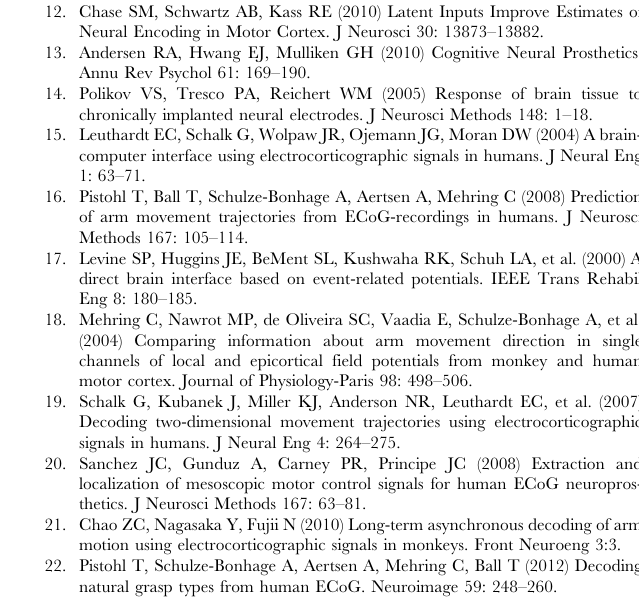
Table S1 Summary of prediction accuracies for 10-fold cross validation of monkey A. Each cell except Avg. shows the CC or the nRMSE (mean 6 STD) of 12 trials. Bold numbers indicate the best value in each test subset. The Avg. cells show the grand averages of mean and SEM. Bold numbers here indicate the best grand